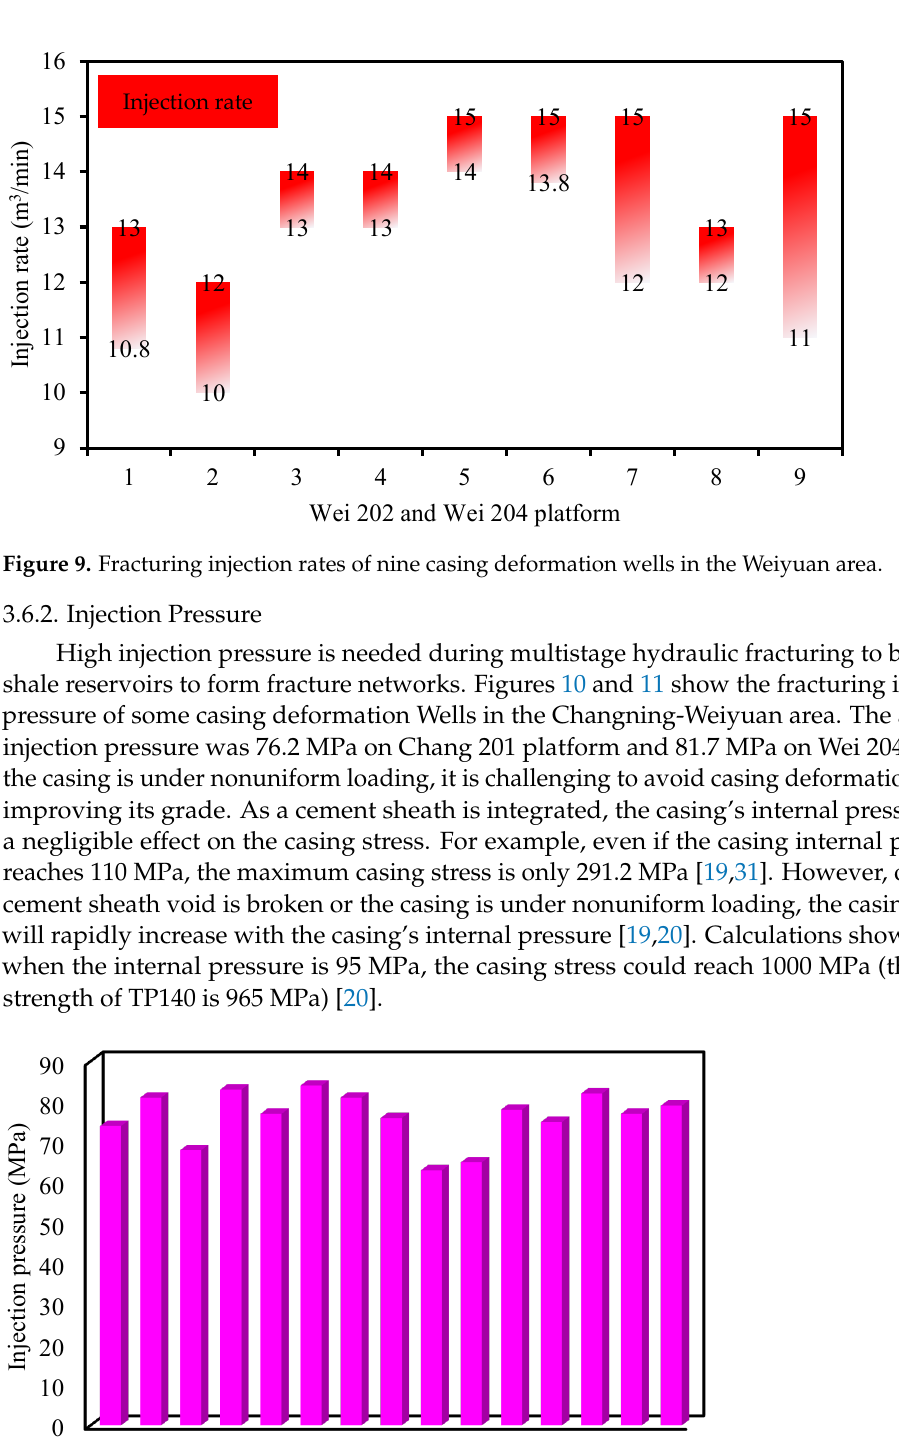
Figure 11. Fracturing injection pressure of 15 deformed casing wells in the Weiyuan 204 platform. 4. Analysis of Relationship between Influence Factors Two or more influencing factors are required to deform the casing. Based on the fre- quency of casing deformation caused by these influencing factors, we have summarized the effect degree of these influencing factors, as shown in Table 2. The fracture/fault slip and microseisms are the strong influence factors and the leading cause of casing defor- mation. They can cause casing deformation. Casing wear, temperature, non-uniform in-